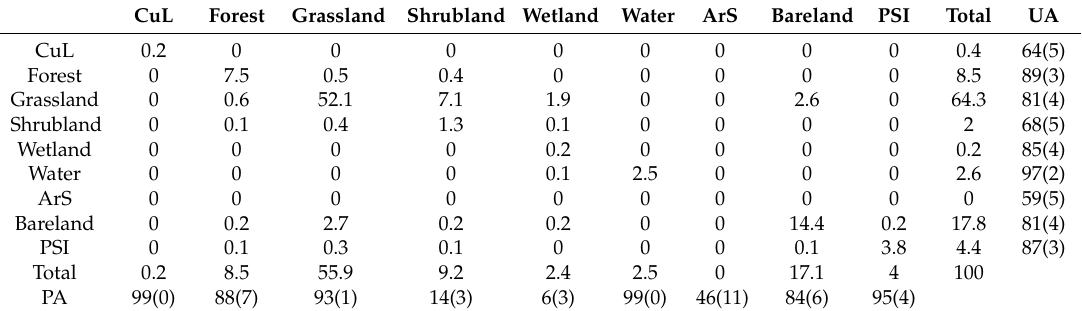
Table A2. The error matrix of estimated area proportions for R2: Overall accuracy is 82.0% (2.7%). CuL